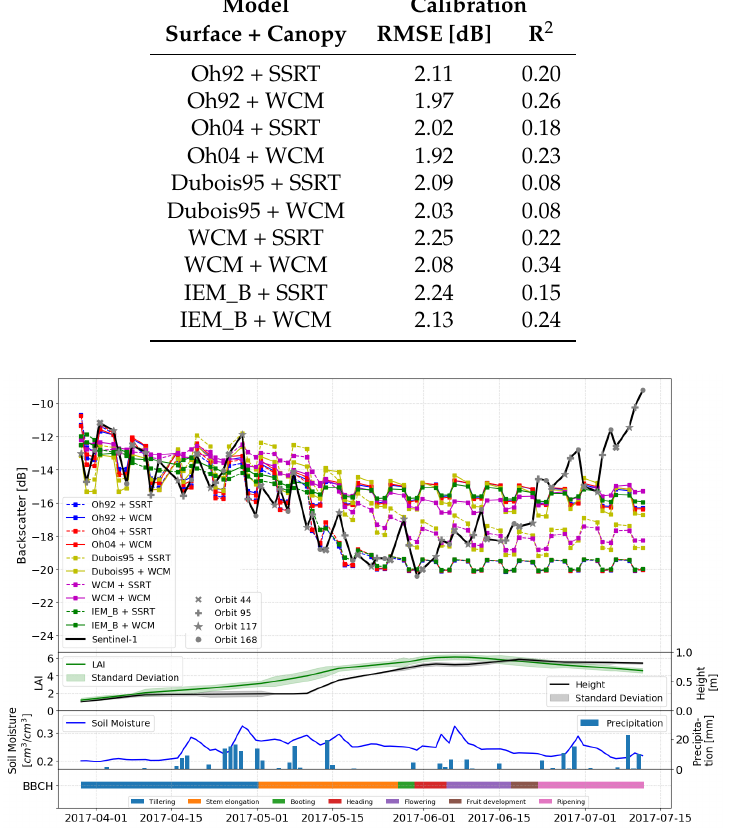
Figure 4. Measured and modeled data (static parameters) of wheat field 508 for vegetation period 2017. VV-polarized backscatter comparison of different model combinations (surface + canopy) with static empirical parameters and Sentinel-1 data. Different icons represent different acquisition geometries of Sentinel-1 ( top ). Field measurements of Leaf Area Index (LAI), canopy height, and soil moisture, as well as precipitation data from meteorological station Freising ( middle ). Observed vegetation phenology according to BBCH scale [84] ( bottom ).